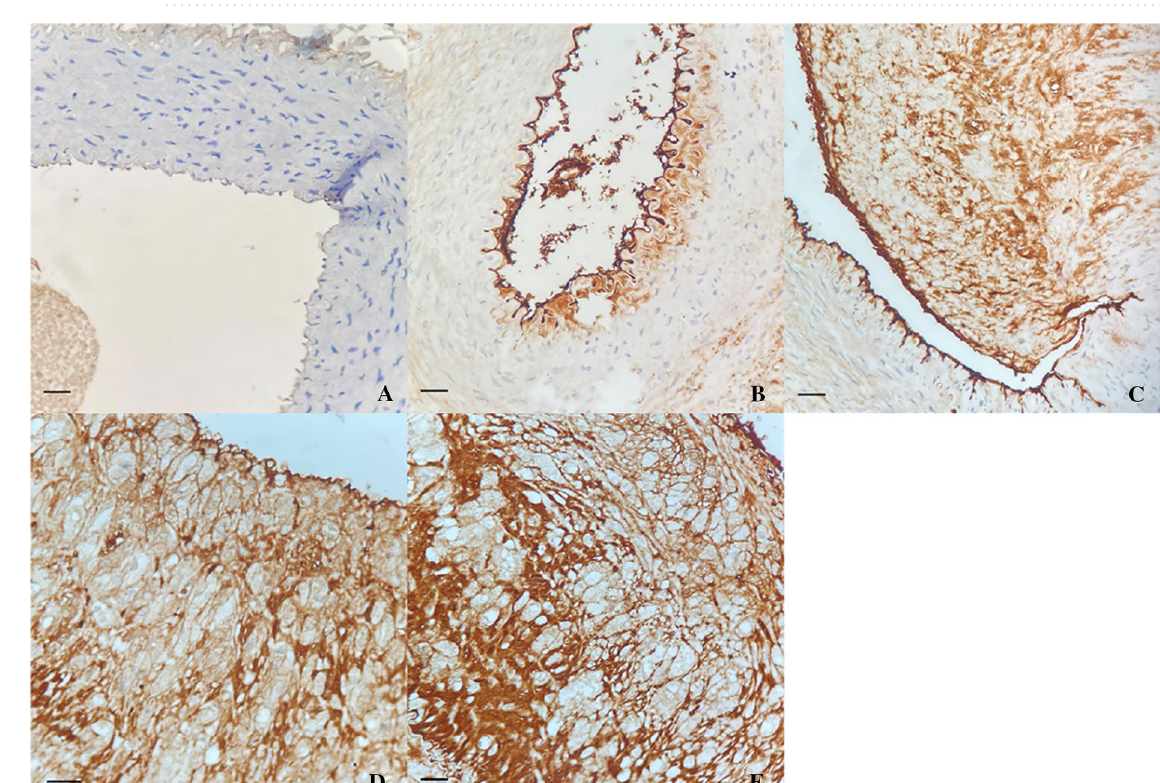
Figure 8. Expression of ICAM-1(× 400). Yellowish-brown granules were deposited in vascular endothelialcells, smooth muscle cells, macrophages and foam cells. Control group stained negative for ICAM-1; Week-4, 8, 12, 16 groups stained positive for ICAM-1. scale bar shows 25